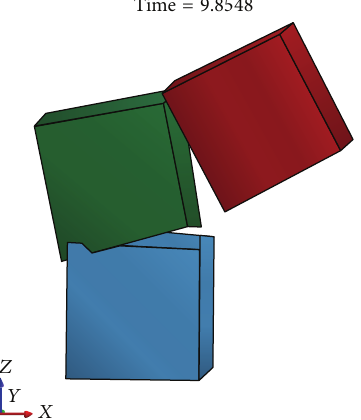
Figure 7: Block impact under the breakaway conditions in (1) (9.8 sec).